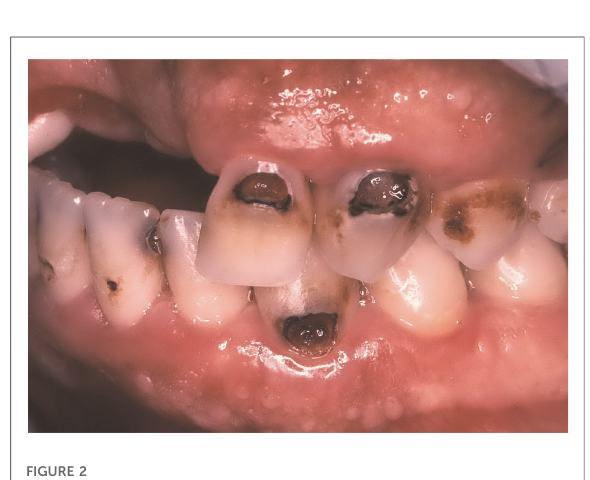
FIGURE 2 Clinical image of root